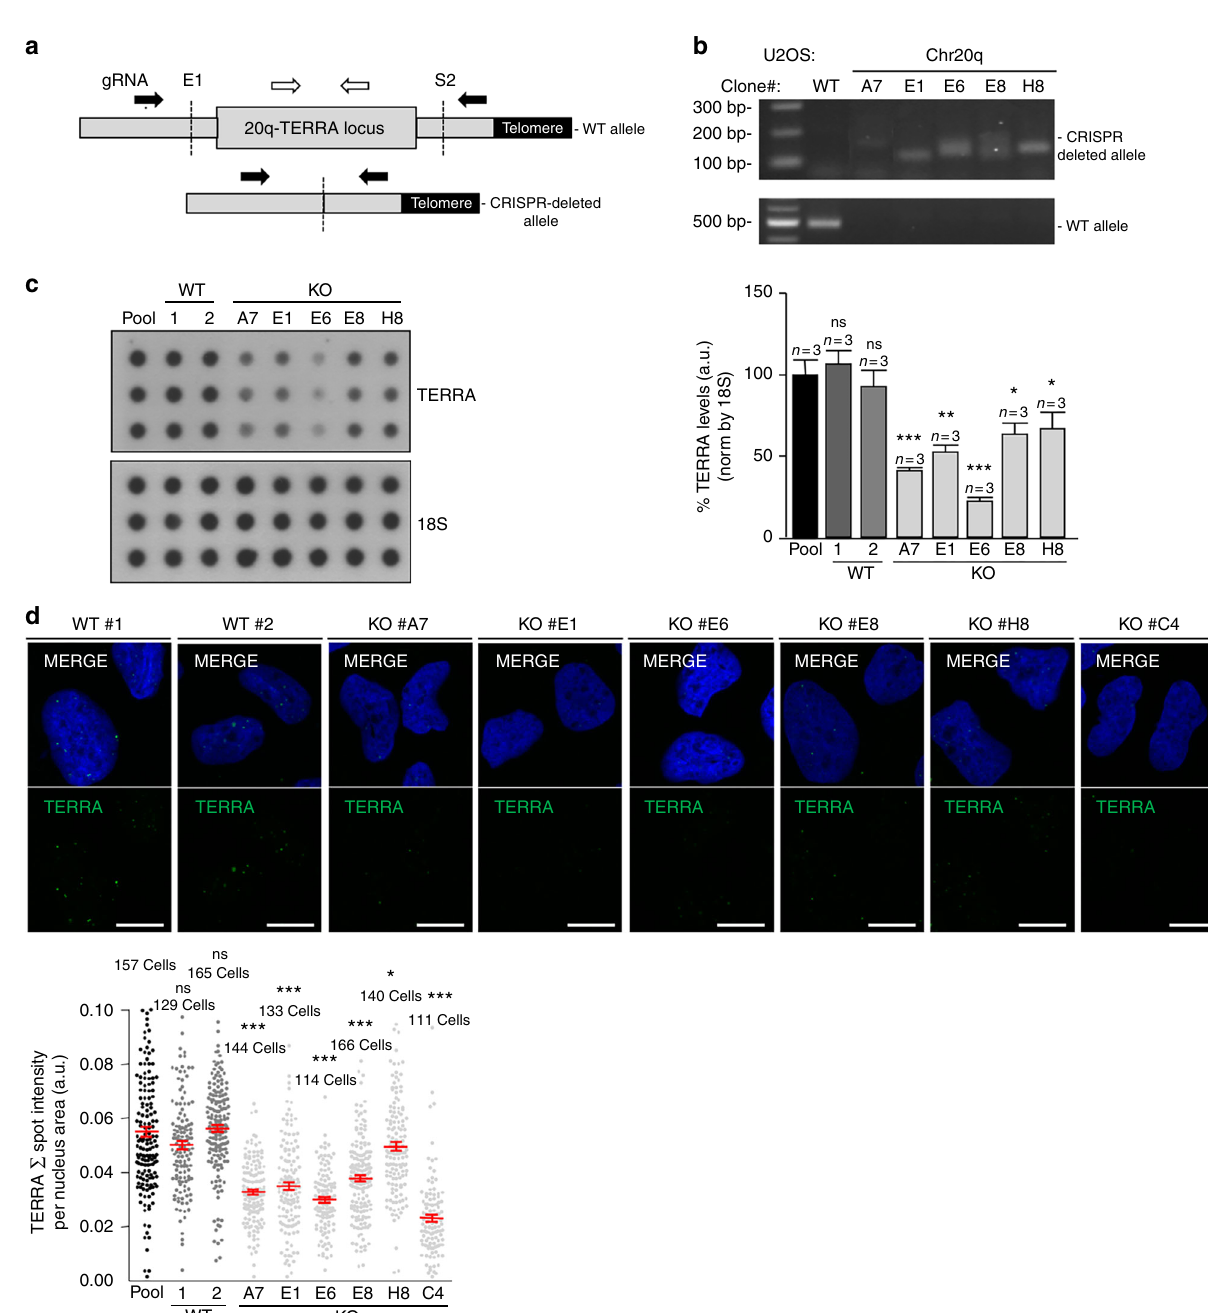
Fig. 1 Deletion of the TERRA-20q locus markedly affects TERRA expression. a Scheme depicting the WT and the CRISPR-deleted allele for the 20q-TERRA locus located in the subtelomere of the chromosome 20, q-arm. The position of the gRNAs (E1 and S2) and the primers used to genotype the deletions are also shown. The black arrows represent the primers to amplify the CRISPR-deleted allele and the white arrows the ones to amplify the WT allele located inside the 20q-TERRA locus. b Ethidium bromide gels showing the WT and the CRISPR-deleted allele for the 20q-TERRA locus detected by PCR in a WT cellular pool and in different clones of the U2OS cells. c RNA from the a WT cellular pool, WT expanded clones (#1 and 2), or 20q-TERRA KO clones (#A7, E1, E6, E8, and H8) from the USOS cell line was isolated and used for TERRA detection by RNA dot-blot with a probe against the TERRA-UUAGGG-tract; 18S serves as loading control. (Graph) TERRA quanti fi cation normalized by 18S (mean values± s.e.m., n = 3 biological replicates). d Representative confocal microscopy images of RNA-FISH against TERRA-UUAGGG-tract (green) in the U2OS WT clones (#1 and 2) and in the 20q-TERRA KO clones (#A7, E1, E6, E8, H8, and C4). Scale bar, 10 μ m. (Graph) Quanti fi cation of the total spot intensity per nucleus normalized by nucleus area (mean values ±